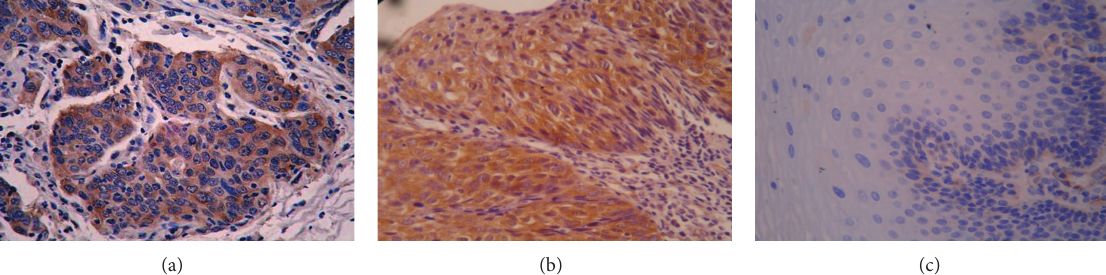
Figure 1: Expression of mTOR in human normal esophageal and ESCC tissues by immunohistochemical analysis. (a) Negative expression of mTOR in normal tissues of the esophagus. (b) Moderate positive expression of mTOR in dysplasia tissues. (c) Positive expression of mTOR in ESCC tissues ( × 400).